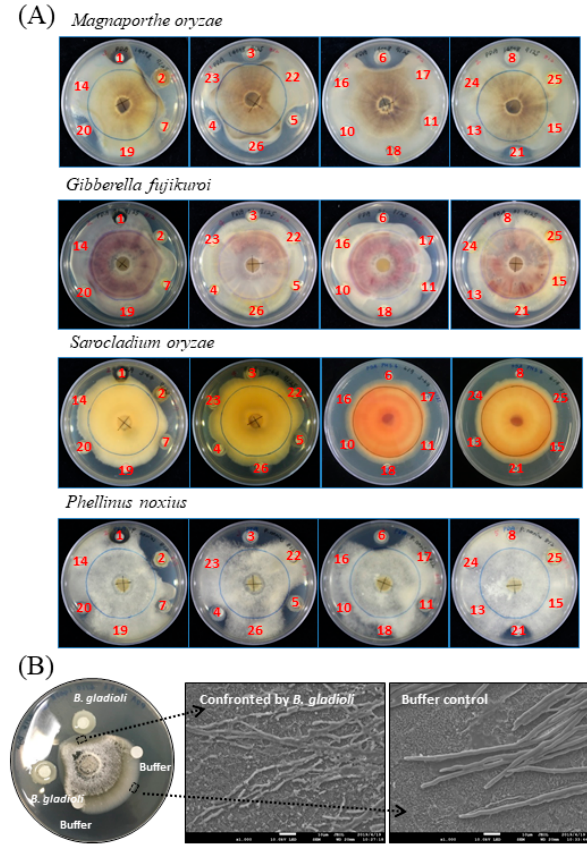
Figure 1. Confrontation assay between pathogenic fungi and screened microbial species. ( A ) The challenged fungus, as indicated, grew radially from the center of the plate, while the screened microbial species were placed outside and surround the mycelial colony as described in Section 4. The screened microbial species and the isolation site, in parentheses, are as follows: #1, Aureobasidium melanogenum (beehive); #2, Burkholderia gladioli (rice shoot); #3, Pseudomonas aeruginosa (spoiled food); #4, P. aeruginosa (spoiled food); #5, P. aeruginosa (mealworm); #6, P. aeruginosa (mealworm); #7, Dyella yeojuensis (urban soil); #8, Serratia marcescens (bamboo forest soil); #10, P. aeruginosa (rice field); #11, P. aeruginosa (rice field); #13, S. marcescens (rice field); #14, Aeromonas sp. (rice field); #15, S. marcescens (cigarette beetle); #16, S. marcescens (cigarette beetle); #17, S. marcescens (riverbank soil); #18, S. marcescens (riverbank soil); #19, Bacillus sp. (poultry feather); #20, Burkholderia cepacia (urban soil); #21, P. aeruginosa (urban soil); #22, S. marcescens (urban soil); #23, P. aeruginosa (urban soil); #24, Stenotrophomonas nitrireducens (used coffee grounds); #25, Sphingobium yanoikuyae (used coffee grounds). #26, Pseudomonas sp. (alkaline soil) ( B ) Morphology change of M. oryzae in response to the confrontation against B. gladioli BBB-01 was examined under a scanning electron microscope as described in Section 4. The mycelia within the dashed line-enclosed area were taken and observed. The scale bar in photos represents 10 µ